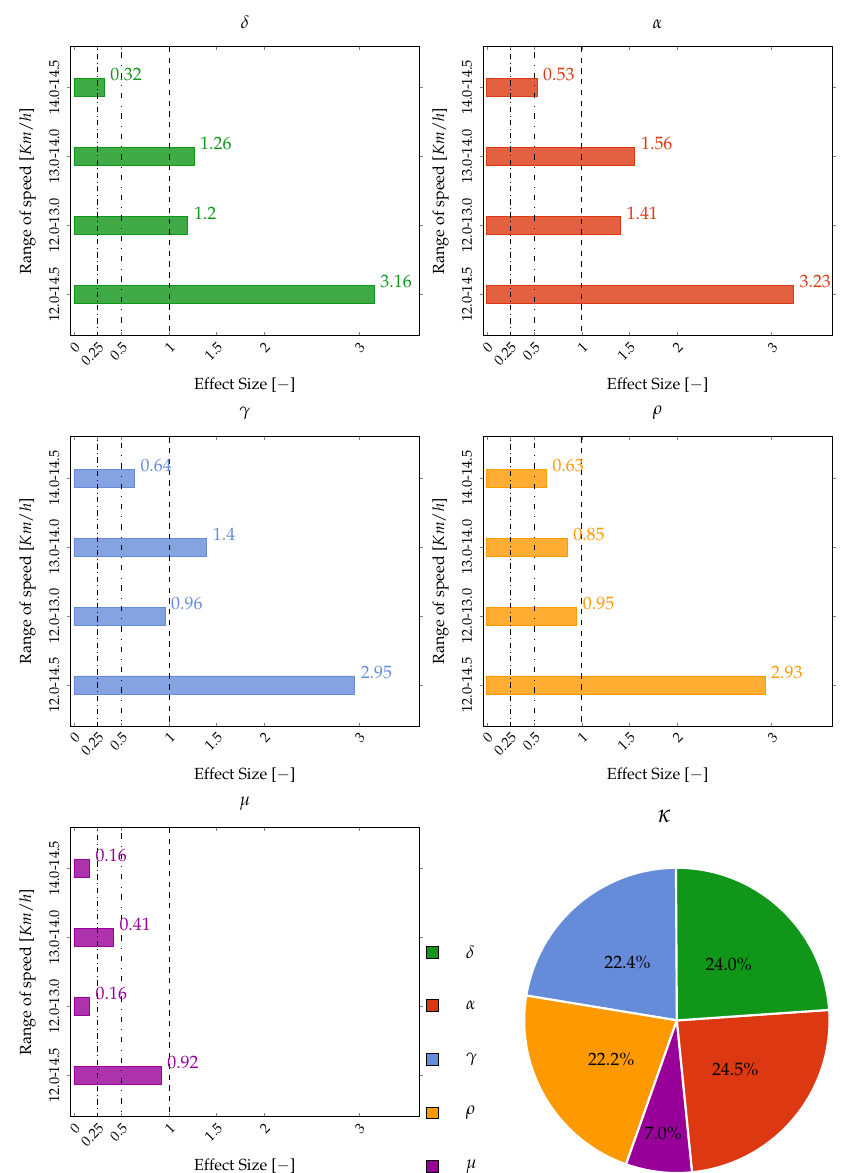
Figure 15. ES bar plots. Dash-dotted lines, trivial values of ES ; loosely dash dotted lines, small values of ES ; dashed lines, moderate values of ES . Only the the ES values over the lines of moderate values can be considered large values. The pie graph in the bottom right shows the percentage values of κ for all the indices.